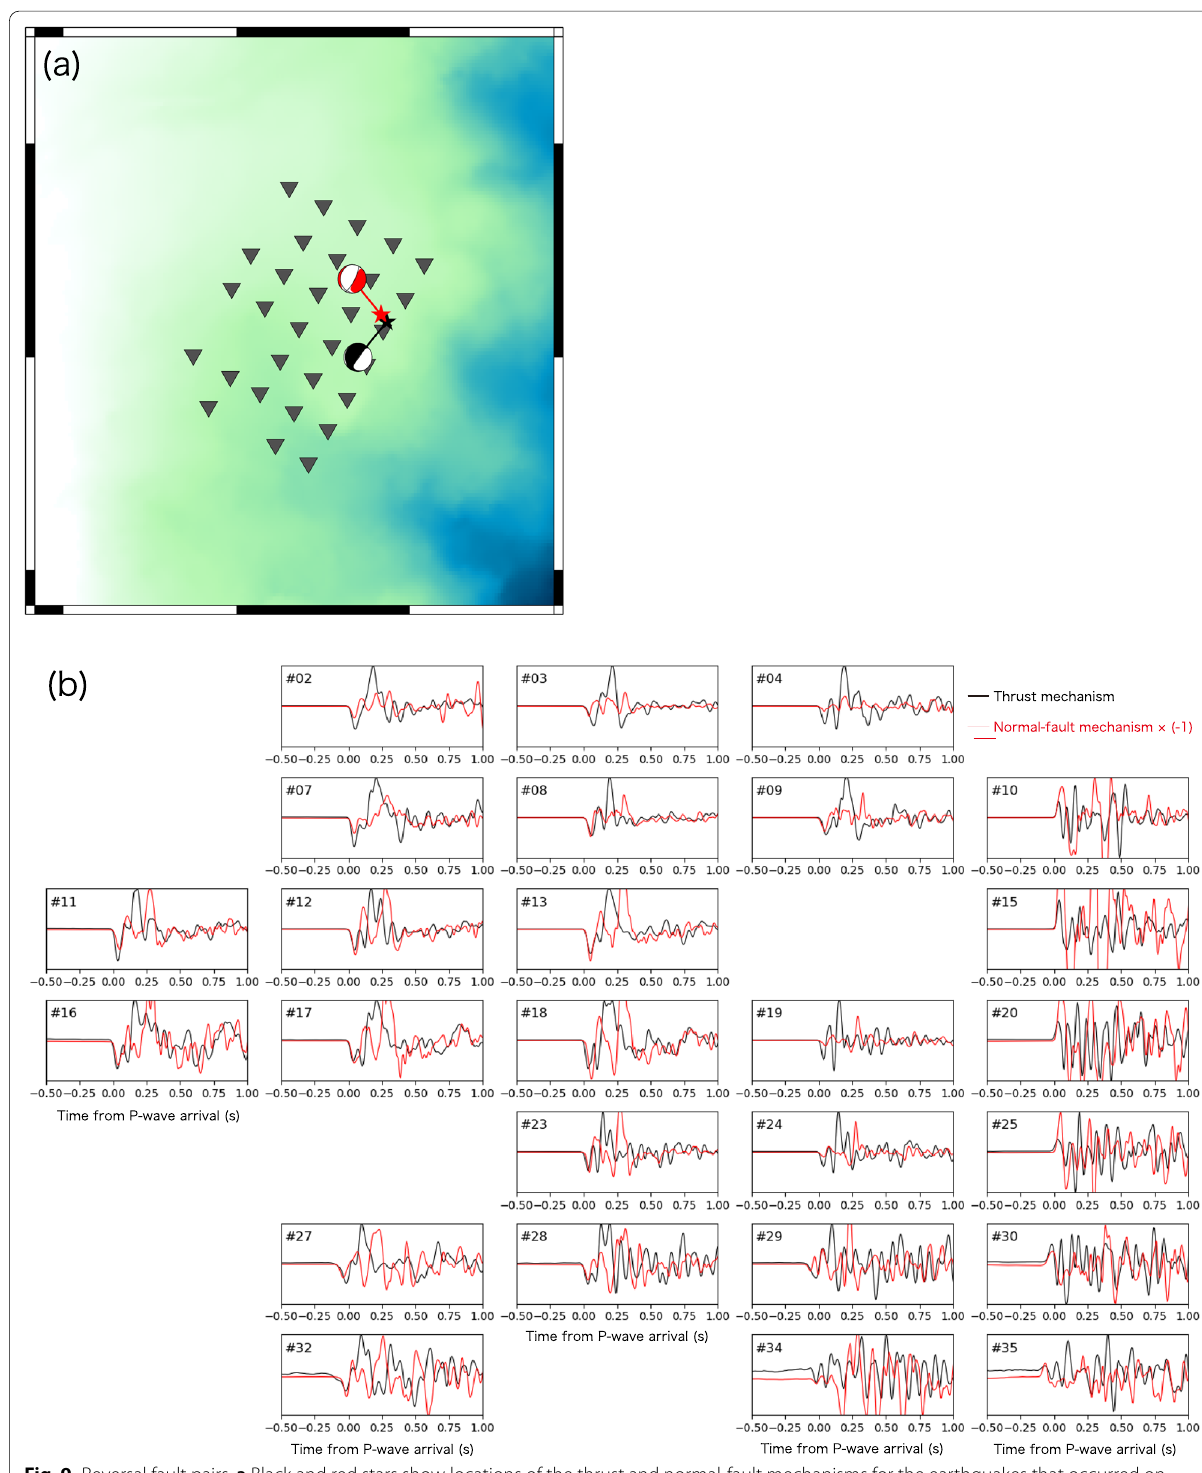
Fig. 9 Reversal fault pairs. a Black and red stars show locations of the thrust and normal-fault mechanisms for the earthquakes that occurred on April 12 and 30, 2011 (JST), respectively. The depths were 15 km and 12 km, respectively. b Raw seismogram comparison between the earthquakes. Black lines show the raw seismograms for the thrust mechanism, and red lines show the reversal amplitudes of those for the normal-fault